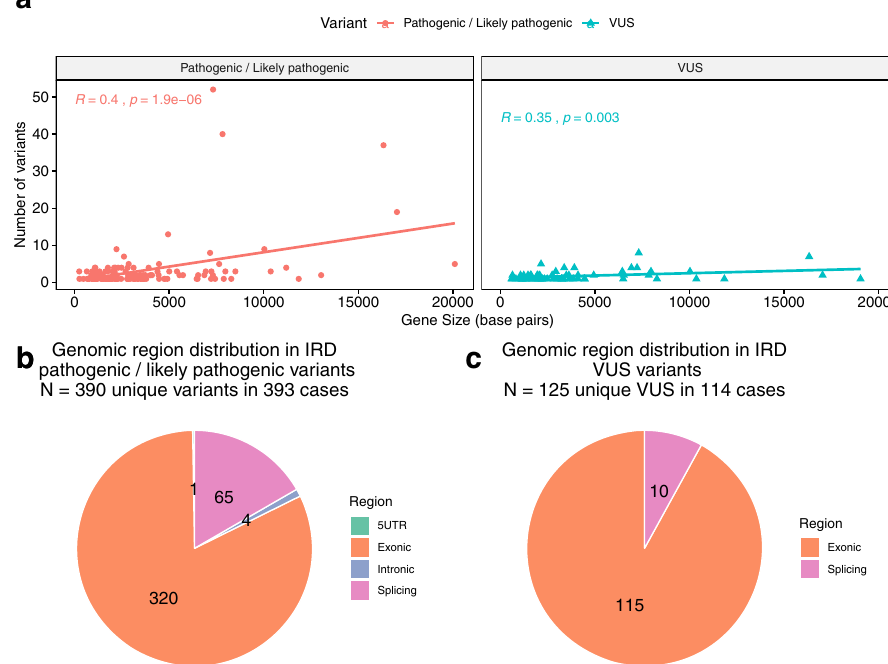
Fig. 3 Gene size and genomic region distribution. Correlation between gene size and number of pathogenic/likely pathogenic and VUS variants found ( a ) and genomic region distribution of pathogenic/likely pathogenic variants ( b ) and VUS ( c